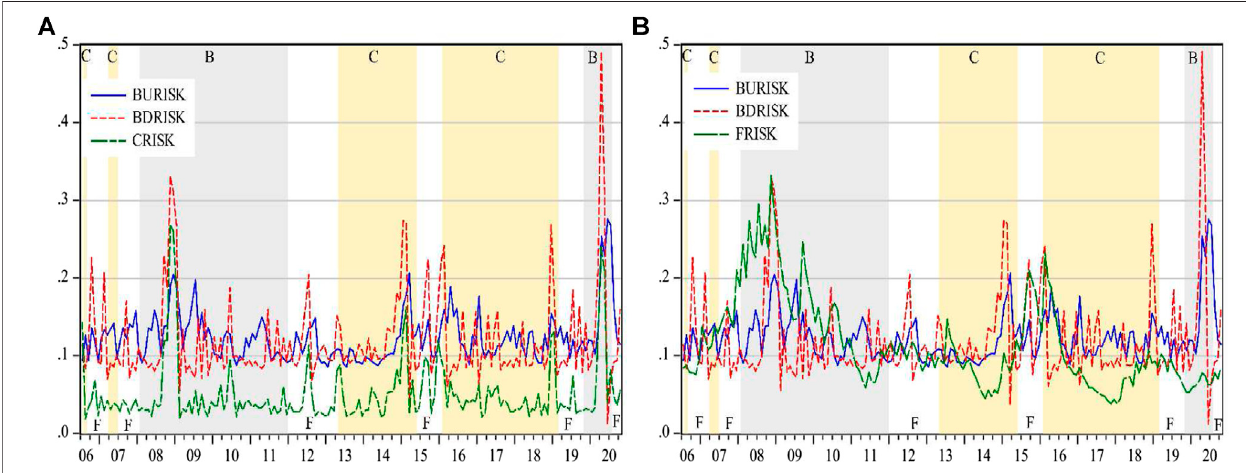
FIGURE 2 | Risk dynamics of the international crude oil market, commodity market, and fi nancial market. (A) Risk evolutions of the international crude oil market and commodity market. (B) Risk evolutions of the international crude oil market and fi nancialmarket.BURISK and BDRISK represent the upside riskand downside risk, respectively. CRISK is the commodity market risk. FRISK is the fi nancial market risk. B means that the dual attributes of crude oil are dominant. C means that the commodity attribute of crude oil is dominant. F means that the fi nancial attribute is dominant.